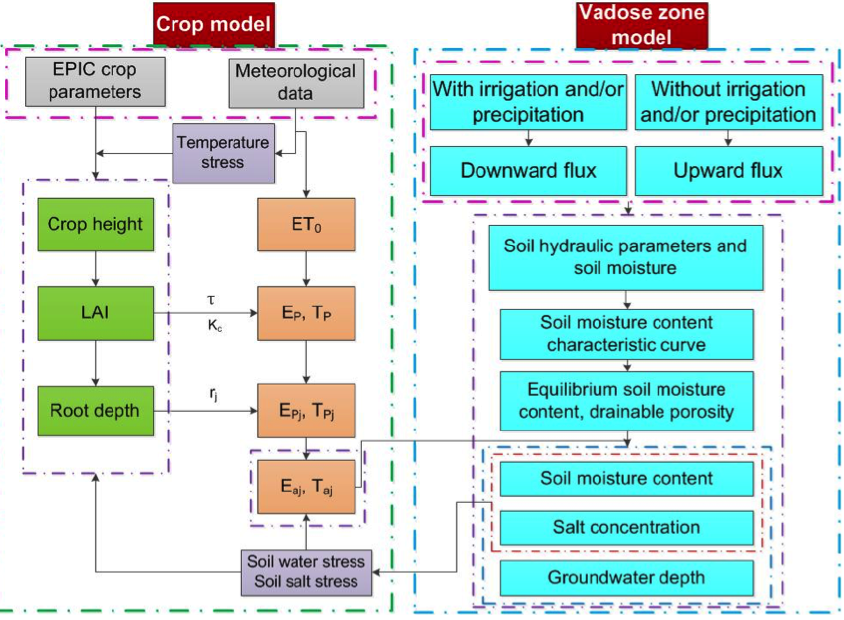
Figure 2. Schematic diagram of the linked novel Shallow Aquifer-Vadose zone surrogate module and EPIC module. Note: ET 0 is the reference evapotranspiration, E p and T p are the potential evaporation and potential transpiration, E a and T a are the actual evaporation and actual transpiration, K c is the crop coefficient, τ is the development stage of the leaf canopy, and r j is the root function of soil layer j